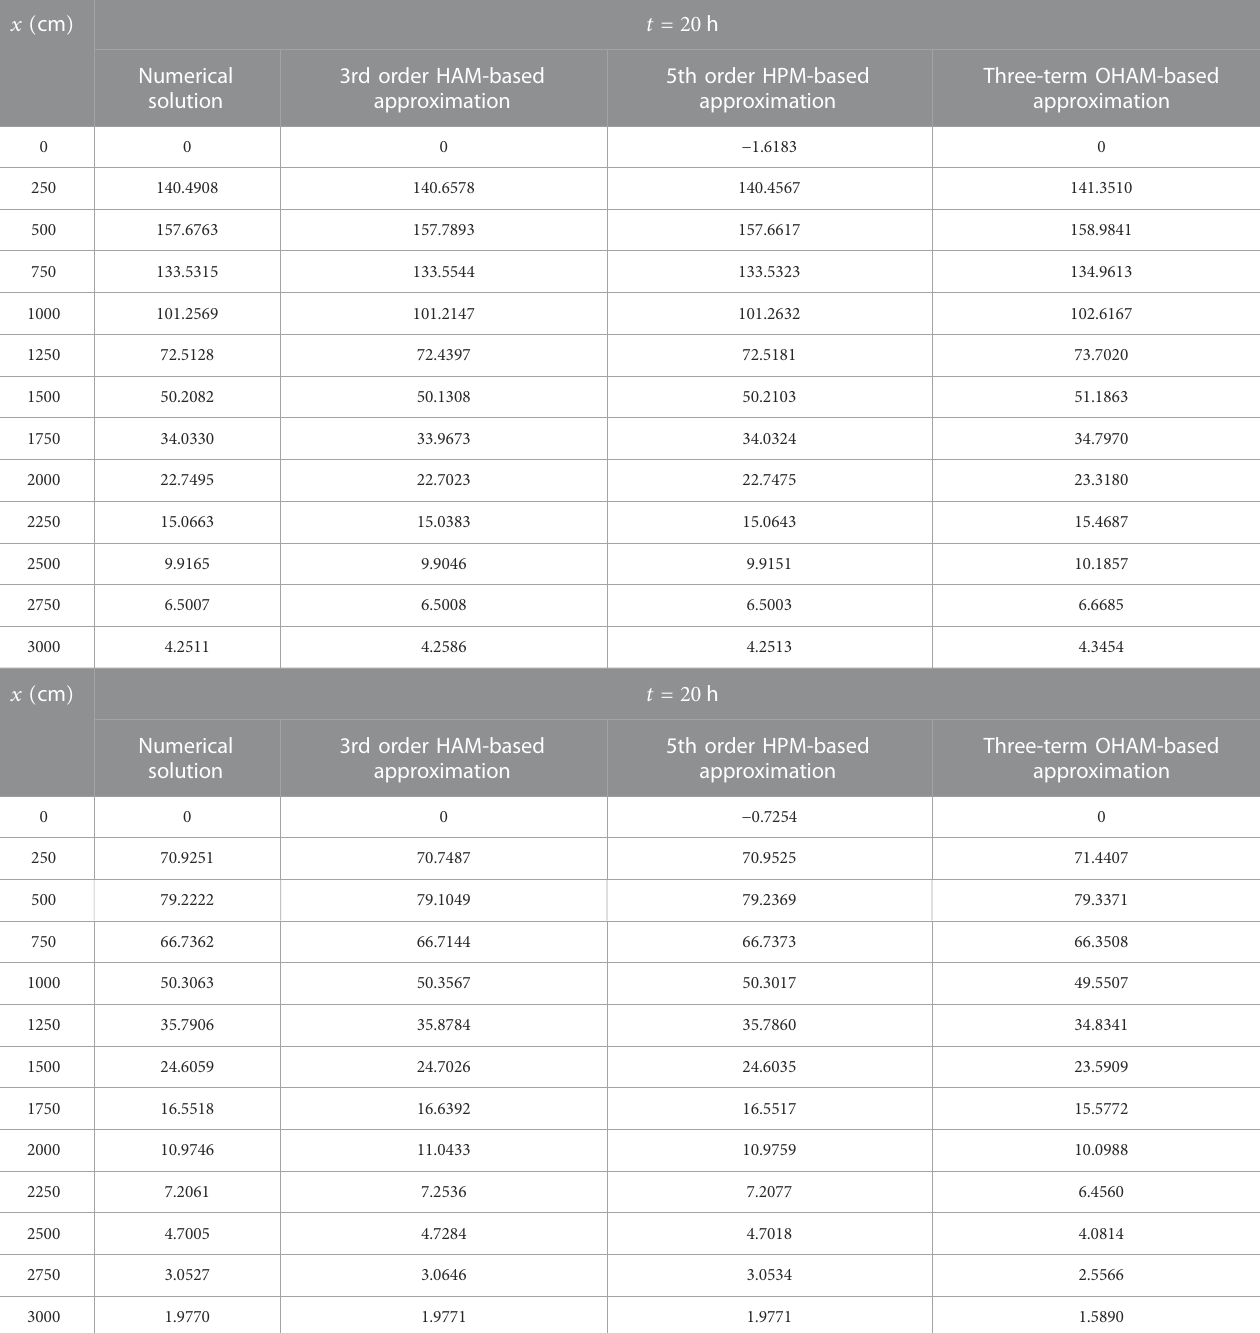
TABLE 2 Comparison between HAM-, HPM-, and OHAM-based approximations and numerical solution for the selected case for t (cid:2) 20 hr: (a) C ( x,t ) (b) Species, C ( x,t Species, C 1 2